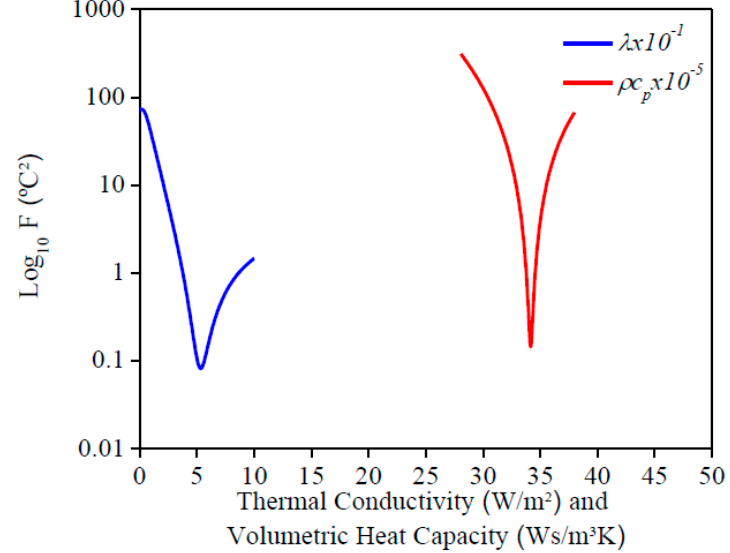
Figure 4. Values of F (Equation (6)) for AISI 1045 steel.